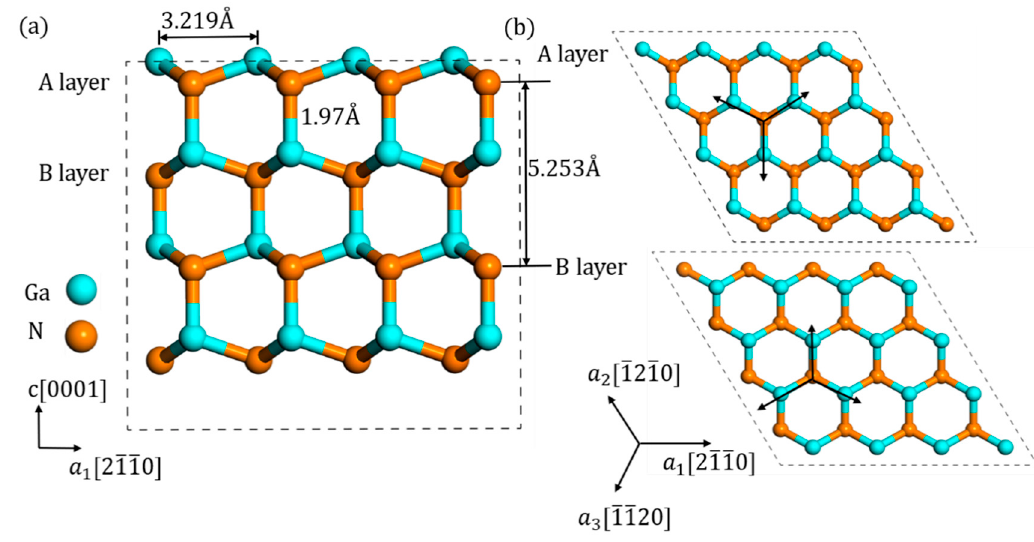
Figure 1. Different view of the structure of wurtzite GaN material: ( a ) side view and ( b ) top view of A layer and B layer.